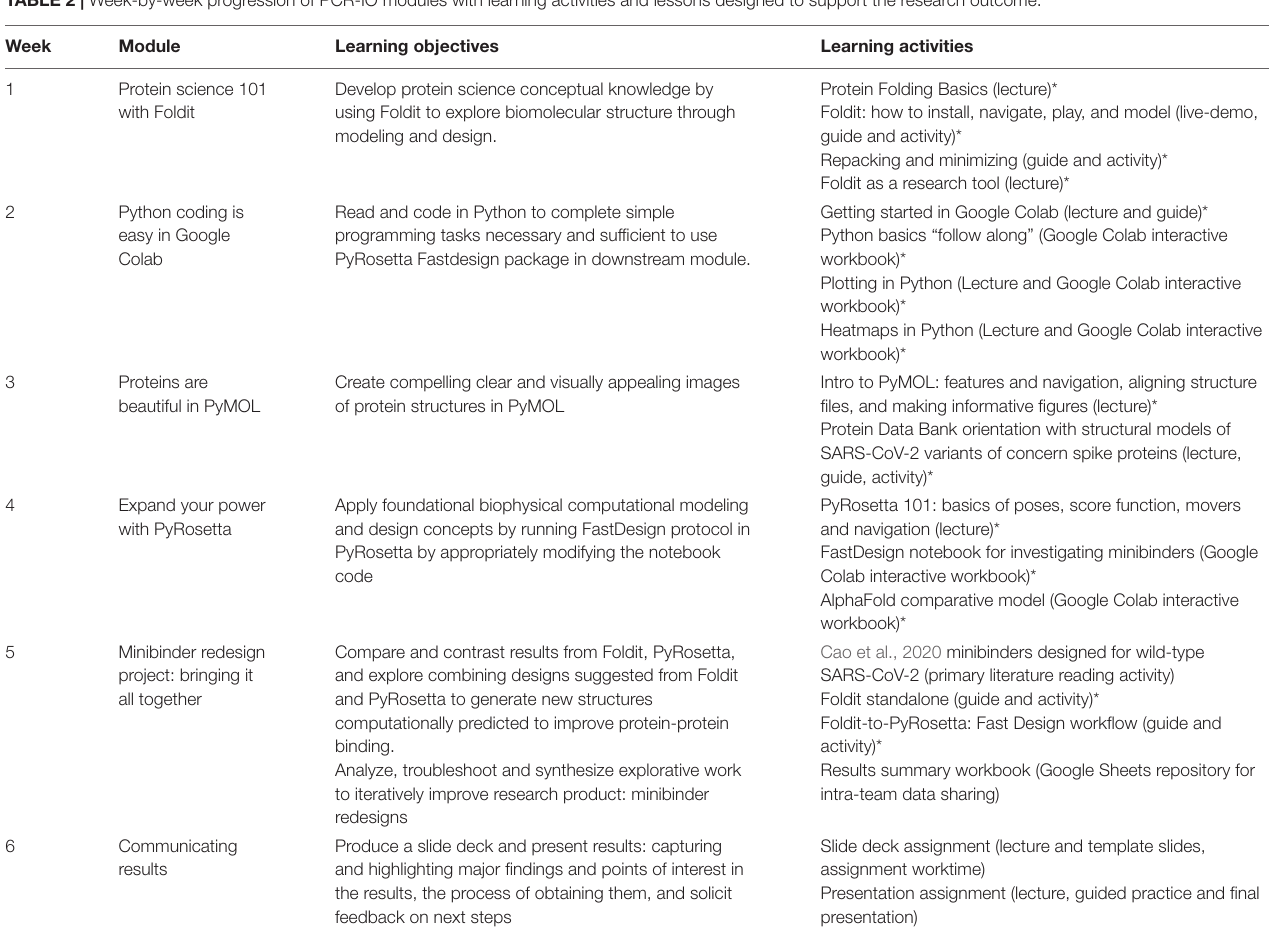
TABLE 2 | Week-by-week progression of PCR-IO modules with learning activities and lessons designed to support the research outcome. Learning